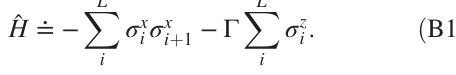
and m z and (b) their 1 ð 2 Þ